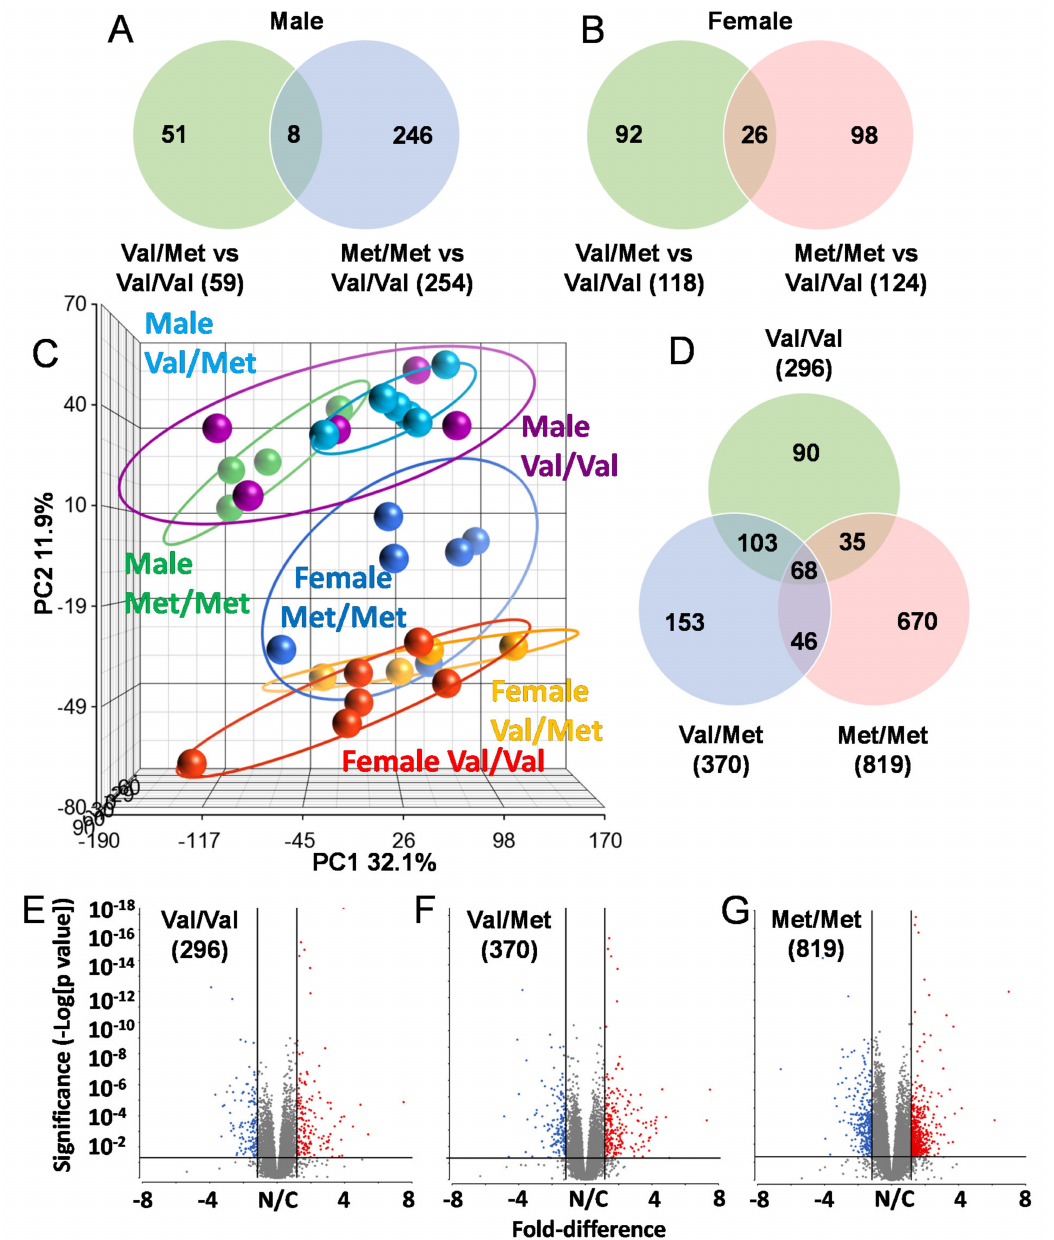
Figure 2. The Met allele increases sex-based differences in global cardiac transcriptional profiles. Venn diagrams showing overlap of differentially expressed genes in whole hearts of male ( A ) and female ( B ) Val/Met versus Val/Val mice compared to those altered in Met/Met versus Val/Val mice. ( C ) Principal components analysis (PCA) shows unique whole heart male and female expression profiles in Val66Met mice. Groups are as indicated and colored as follows: purple = Male Val/Val, teal = Male Val/Met, green = Male Met/Met, red = Female Val/VaWe did not use any hyphensl, orange = Female Val/Met, blue = Female Met/Met. ( D ) Venn diagram showing overlap in differential genes for direct comparisons of males versus females for each genotype (green = Val/Val, blue = Val/Met, red = Met/Met). ( E – G ), Volcano plots for males versus females for each genotype. The ordinate represents increasing significance, and the abscissa shows magnitude of change. Lines represent significance cutoffs, with numbers of genes significantly differentially expressed shown in parentheses. Red and blue dots represent significant genes more highly expressed in whole hearts of females and males, respectively. Grey dots represent genes not deemed as significantly different ( p > 0.05 and/or fold <